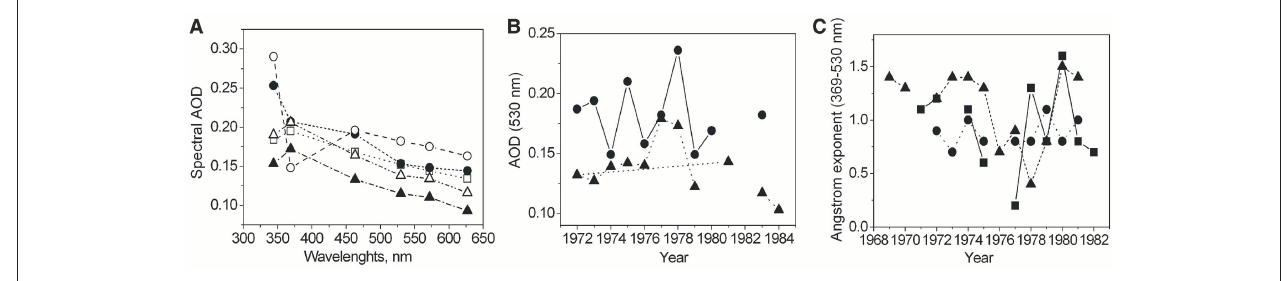
FIGURE 2 | Spectral AOD and Ångström exponent at Lviv, Odessa, and Feodosia/Karadag sites in Ukraine multiyear averaged over the period 1972–1984. (A) Spectral AOD solid symbols—total AOD, open symbols—warm period AOD, (B) AOD (530nm) at Odessa and Feodosia/Karadag sites of Ukraine averaged over warm part of a year for the 1972–1984 period, (C) yearly averaged Ångström exponent (369–530nm) for at Lviv, Odessa, and Feodosia/Karadag sites in Ukraine in the period of 1969–1982. In figures: Lviv (square), Odessa (circle), Feodosia/Karadag (triangle). Plots have been created by data from Gushchin (1988).